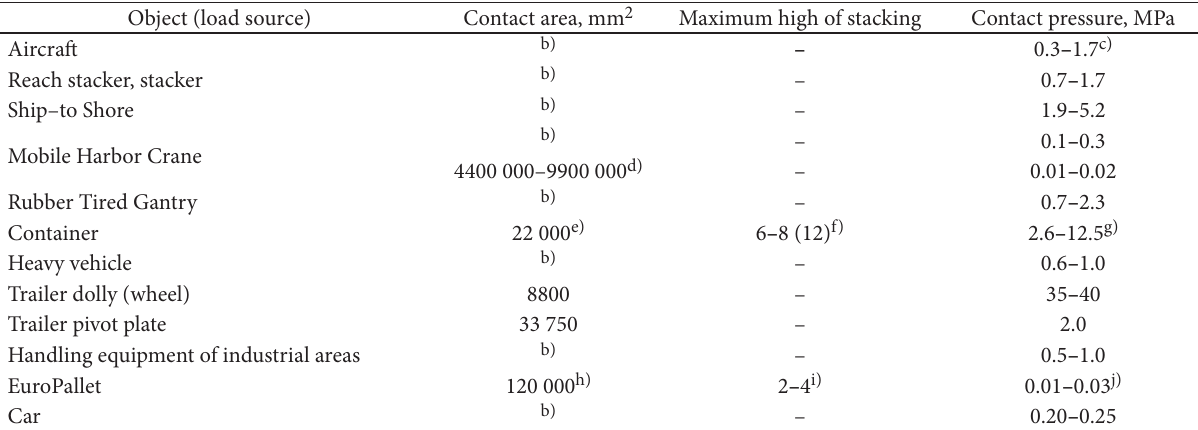
table 1. Contact pressure considering characteristics of load source